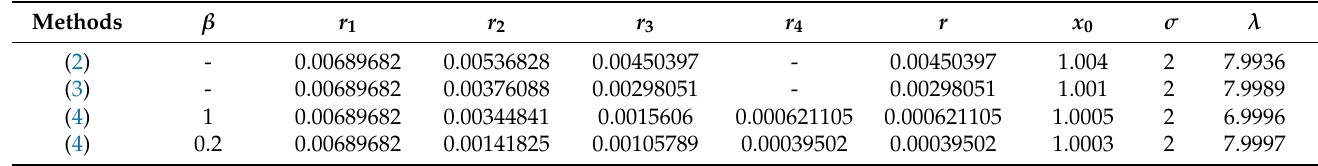
Table 1. Radii for Example 1.